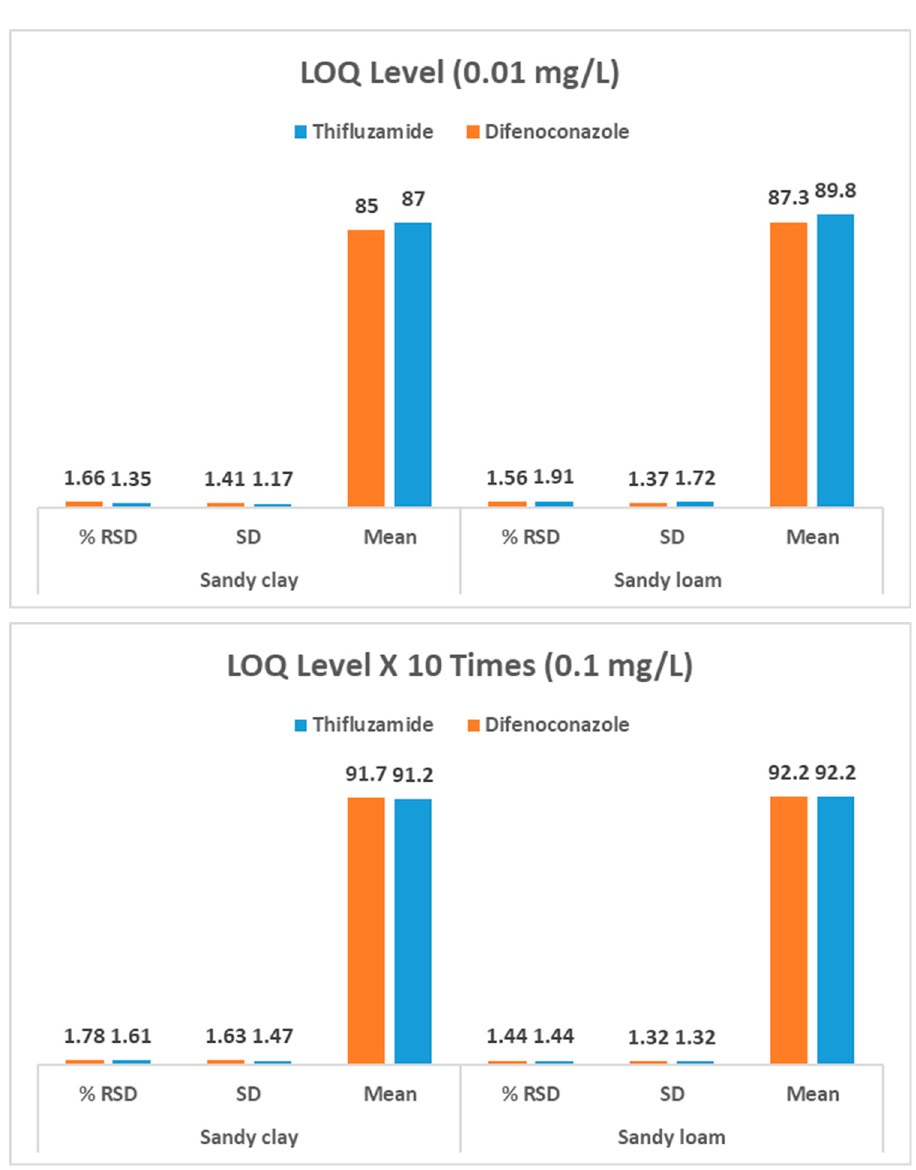
Figure 5. Recovery details of fungicides in soil.